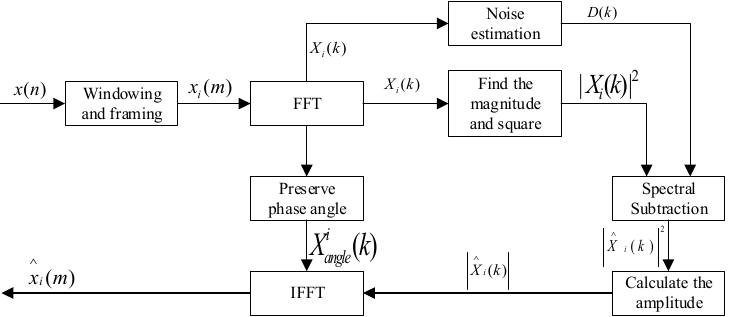
Figure 1. Schematic diagram of Basic Spectral Subtraction.